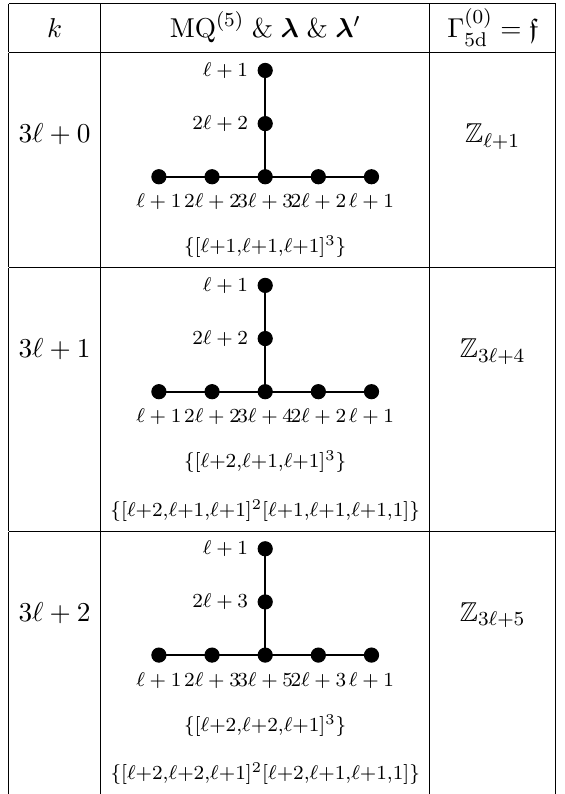
models. The three partitions λ are partitions of N ≡ ∆ 6